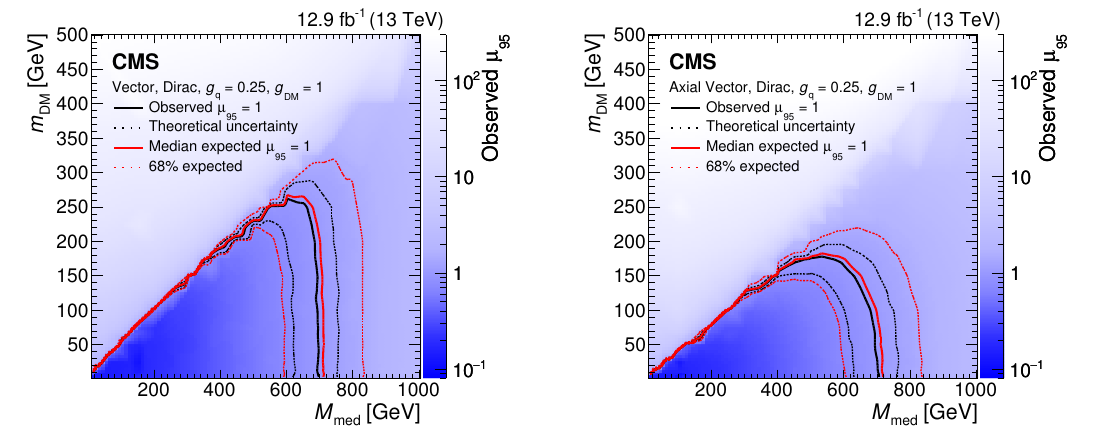
Figure 3 . The ratio of 95% CL cross section upper limits to theoretical cross section ( (cid:22) 95 ), for DM simpli(cid:12)ed models with vector (left) and axial-vector (right) mediators, assuming g q = 0 : 25 and g DM = 1. Expected and observed (cid:22) 95 = 1 contours are overlaid. The region below the observed contour is